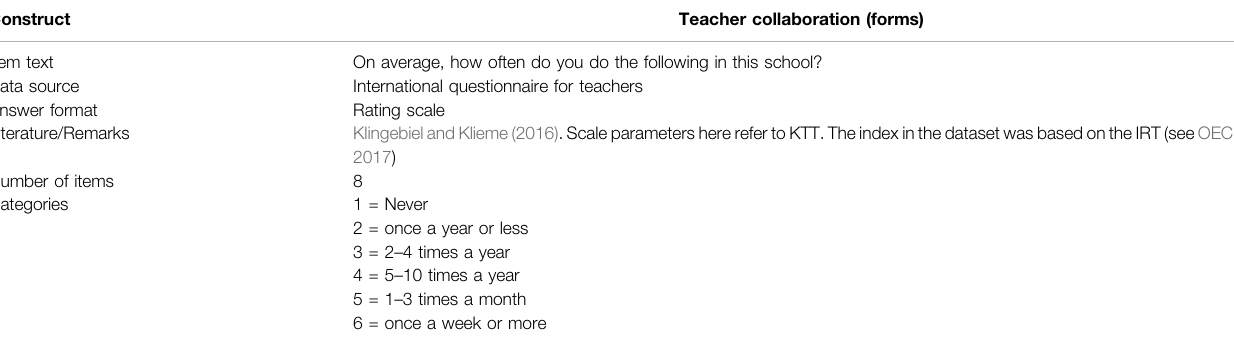
TABLE B1 | Teacher collaboration questionnaire information. Construct